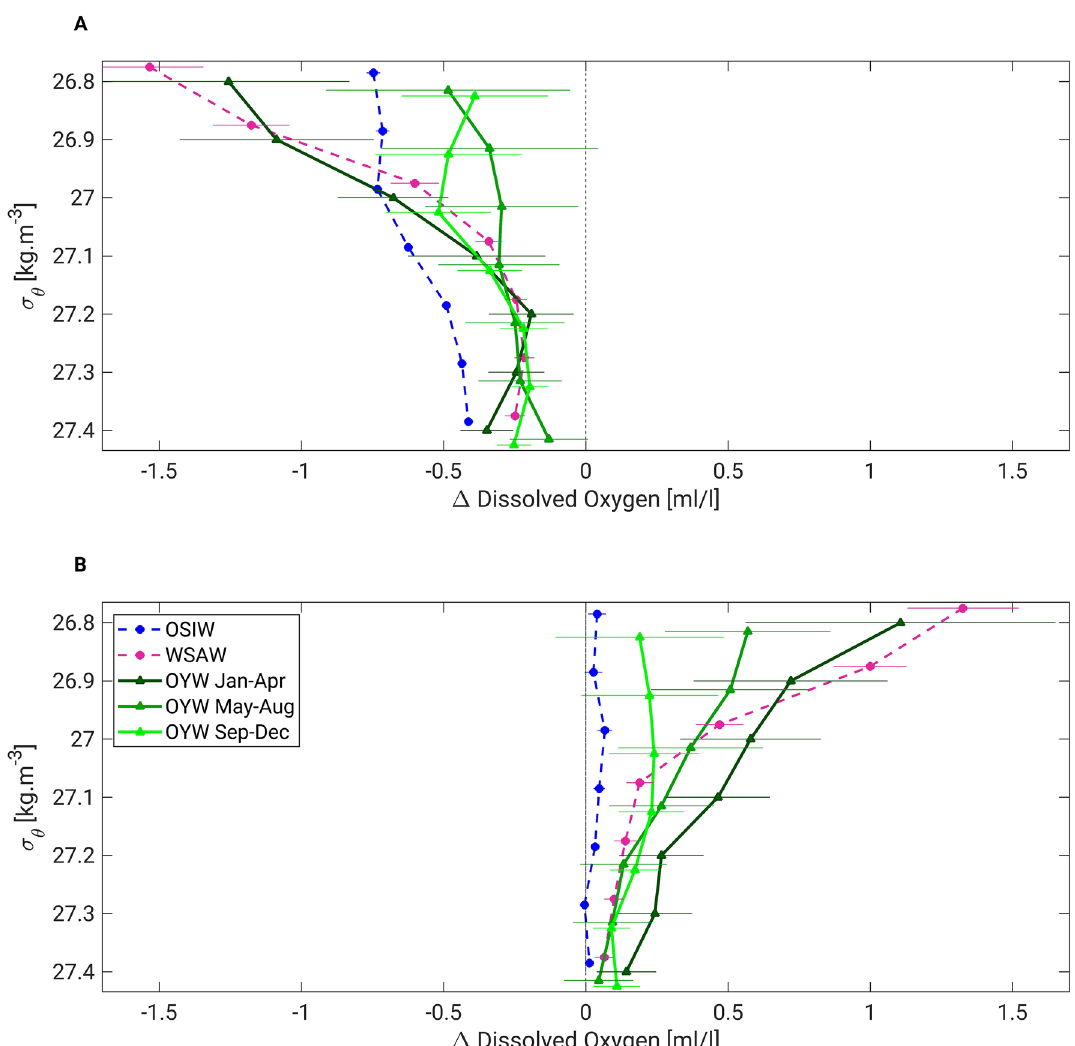
Figure 5. Dissolved oxygen changes due to long-term climate change and the 18.6-year tidal cycle. ( A ) Difference between the 1990–2020 and 1930–1990 climatologies, ( B ) difference between the strong and weak diurnal tide climatologies for OYW from January to April (dark green), May to August (medium green), and September to December (light green). To obtain the OSIW (blue dashed curves) and WSAW (pink dashed curves) values, all available DO data were used, regardless of the season. The error bars represent the 80% confidence interval (see “Methods” for details) for each curve. The data points and corresponding error bars are slightly shifted vertically for